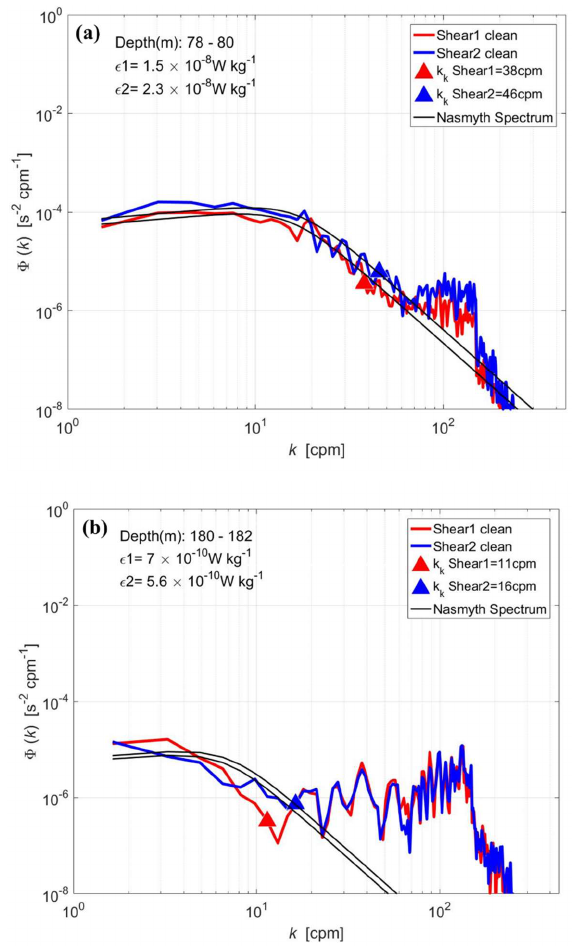
Figure 9. Examples of the shear spectrum at 78–80 m depth ( a ) and low turbulence segment ( b ). The heavy lines (blue lines are from shear probe #1 and red lines are from shear probe #2) represent the shear spectrum after removal of shear variance correlated with vehicle acceleration. The corre- sponding Nasmyth spectrum is indicated by the black line. The arrows (blue, red) indicate the inte- gration limit. The dissipation rate estimate for each shear spectrum is presented in the upper left corner of each plot. 5. Conclusions A CPMTM was designed and manufactured, which consists of multiple turbulence sensors (shear probes and fast-response thermistor), an independent high-speed signal acquisition system, and a flexible connection vibration-damping device. The CPMTM is a small, highly integrated, and versatile instrument package for turbulence measurements that can be easily integrated with a variety of platforms, such as AUVs, gliders, and pro- filing floats, and only requires power and an ON/OFF signal from the supporting plat- form.